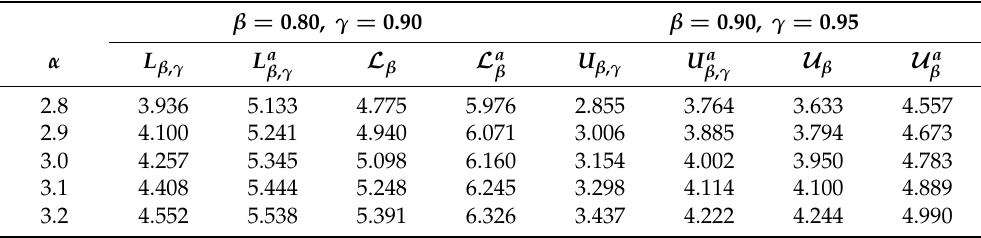
Table 6. Unconditional and conditional lower and upper ( β , γ ) -TLs and β -ETLs for selected values of α around 3 in Example 1. β = 0.80, γ =